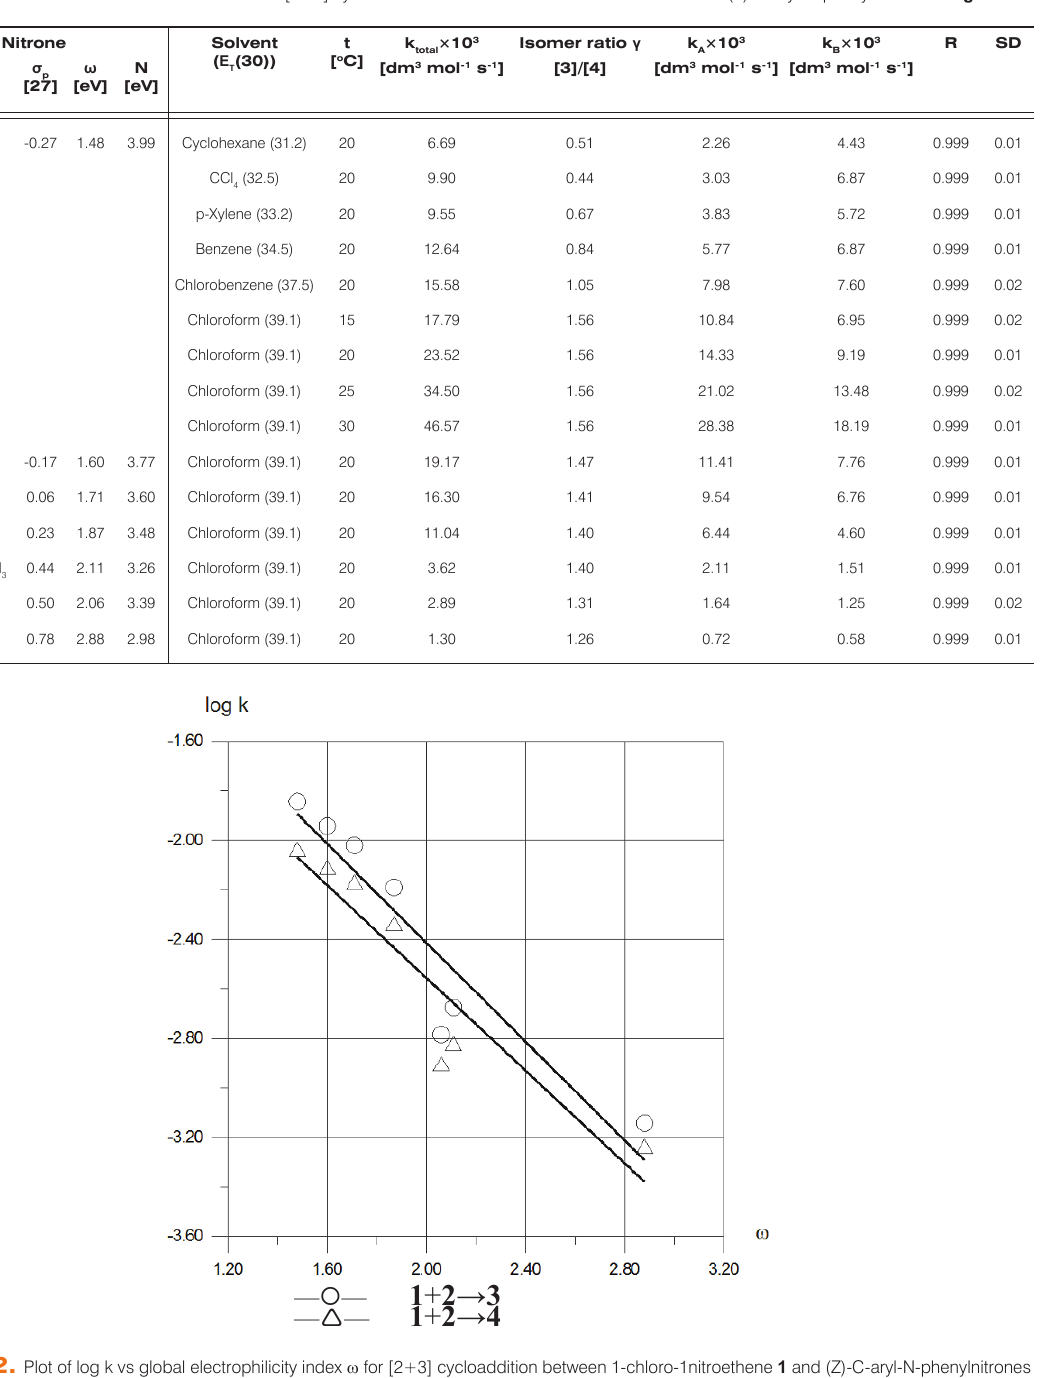
Table 1. Results of kinetic measurements for [2+3] cycloaddition between 1-chloro-1-nitroethene 1 and (Z)-C-aryl-N-phenylnitrones 2a-g .